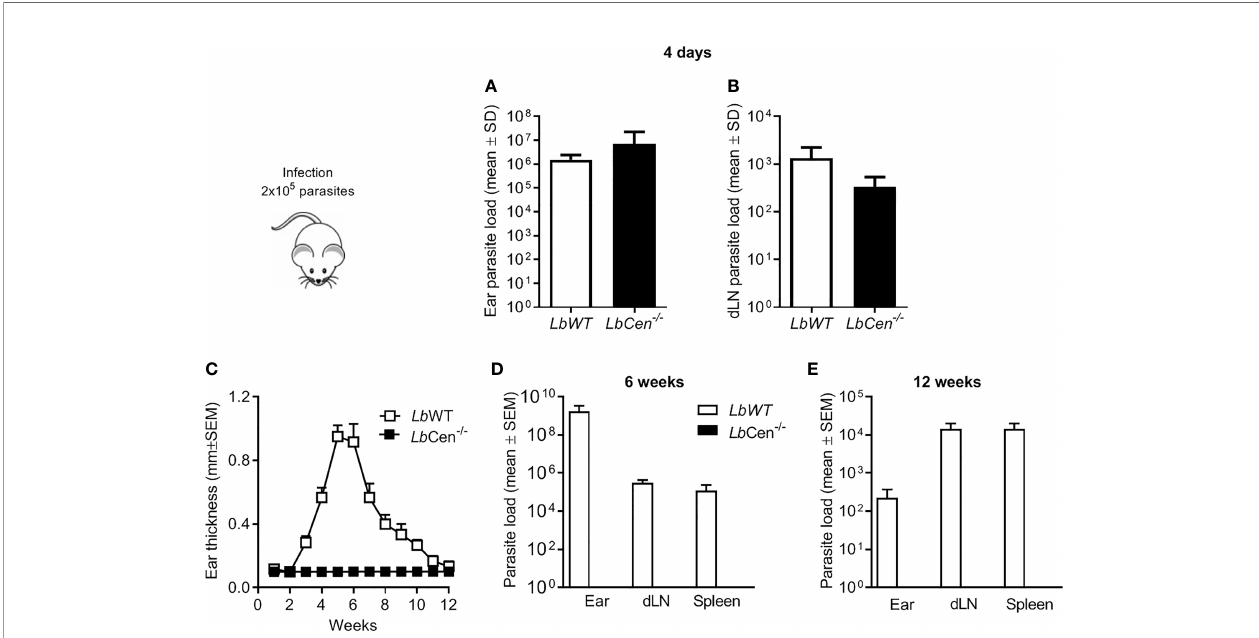
FIGURE 8 | Parasite load in mice inoculated with LbCen − / − . BALB/c mice (10 per group) were infected with 2 × 10 5 LbWT or LbCen − / − promastigotes, in the ear dermis and parasite load was determined, four days later, at the inoculation site (ear) (A) and in draining lymph nodes (B) by Limiting Dilution Analysis. Data (mean ± SEM) are from one representative experiment. BALB/c mice (10 per group) were infected as described and lesion development was measured weekly (C) . Six (D) and twelve (E) weeks post infection, parasite load was evaluated by Limiting Dilution Analysis. Data (mean ± SEM) are from one representative